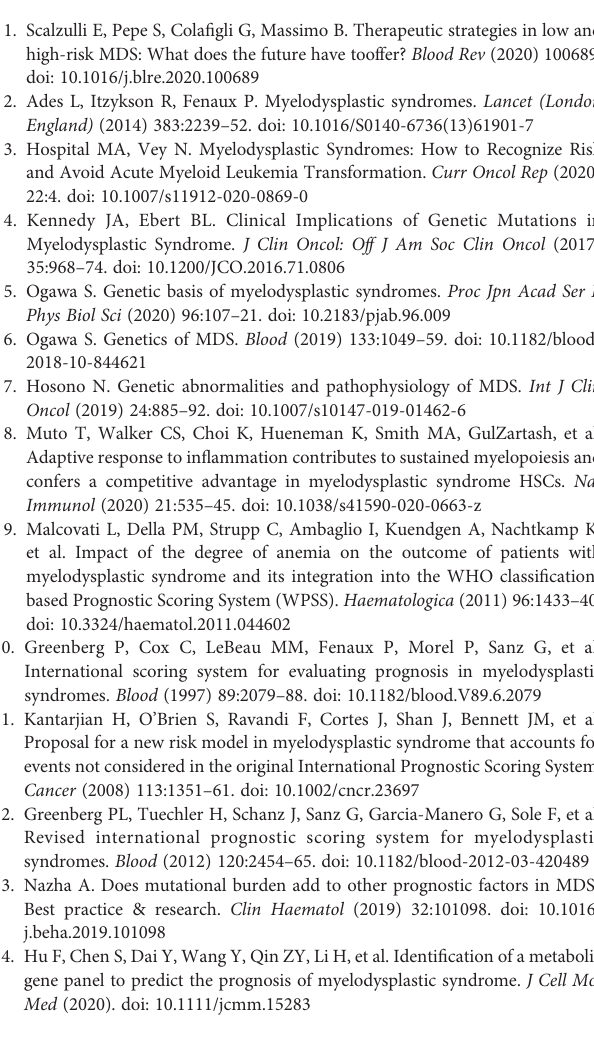
Supplementary Figure 1 | Flowchart showing the development of a prognostic model for MDS based on ARGs. Supplementary Figure 2 | The expression patterns of the ARGs in MDS. 7 prognosis-related ARGs in MDS. Supplementary Figure 3 | The expression patterns of the ARGs in MDS. 93 different expression of ARGs in MDS. Supplementary Figure 4 | Mutationsinprognosis-relatedARGs.This dataset was obtained from cBioportal for Cancer Genomics database, which containing 4,396 MDS samples. The mutation rate of 7 prognosis-related ARGs after multivariate analysis and22 prognosis-related after univariate analysiswere showed in (A , C) . The survival analysis of 7 prognosis-related ARGs were showed in (B)